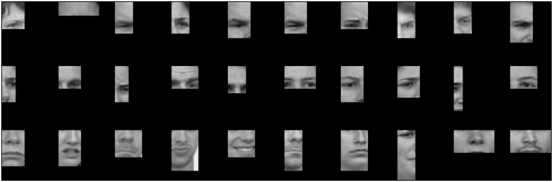
Face fragments with high (top), intermediate (middle) or low (bottom) individuation-specific information.